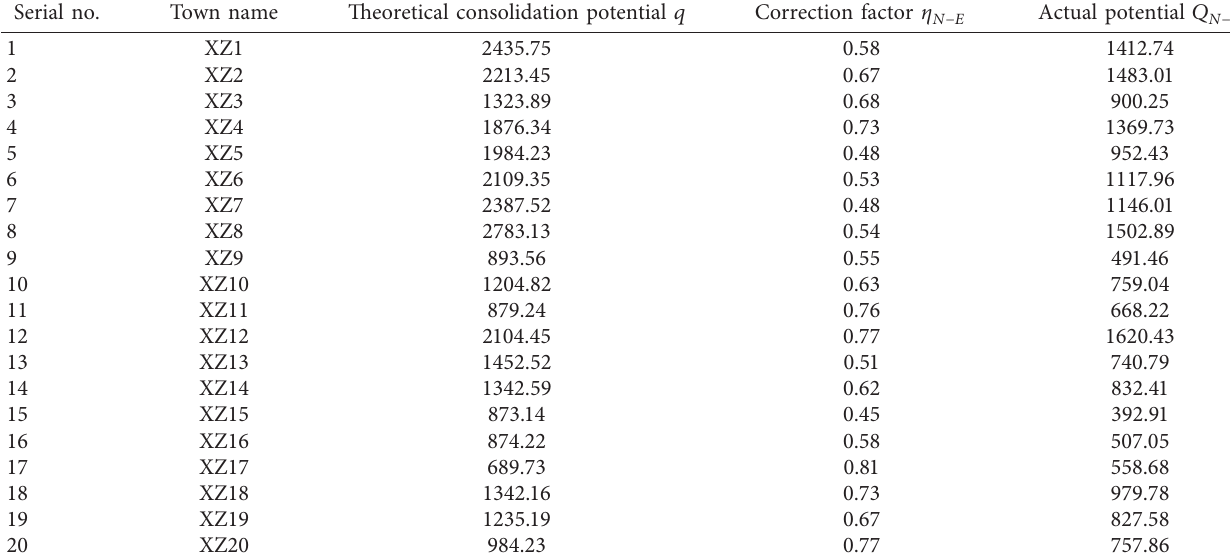
Table 7: Calculation of the realistic potential of rural residential land consolidation based on natural conditions and economic feasibility results for the 20 towns in Rugao. Serial